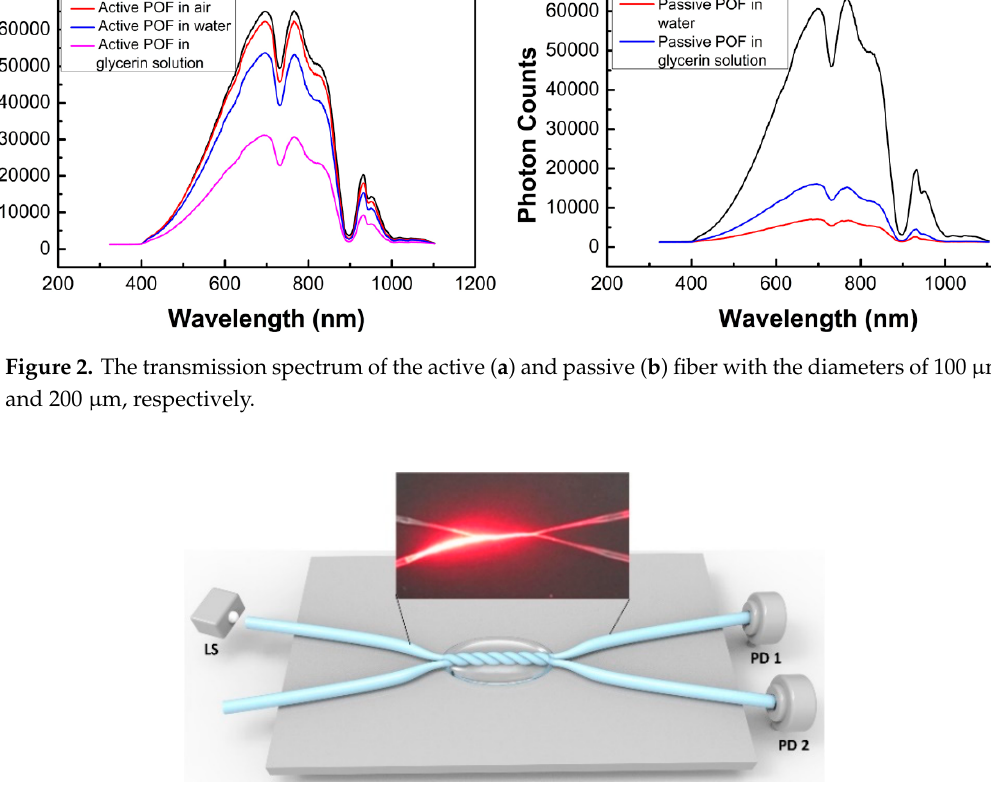
Figure 3. Schematic diagram of the experiment setup. LS is the light source and PD is the photodetector.